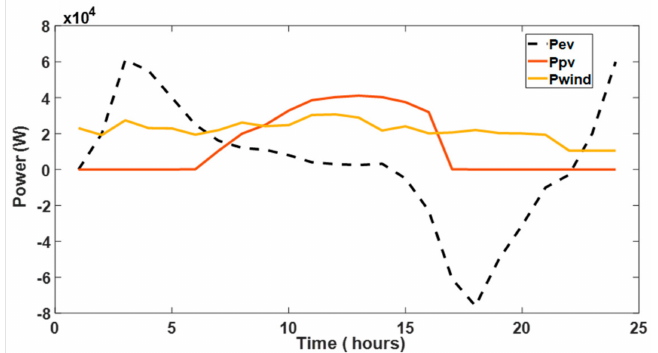
Figure 12. Power variation in 24